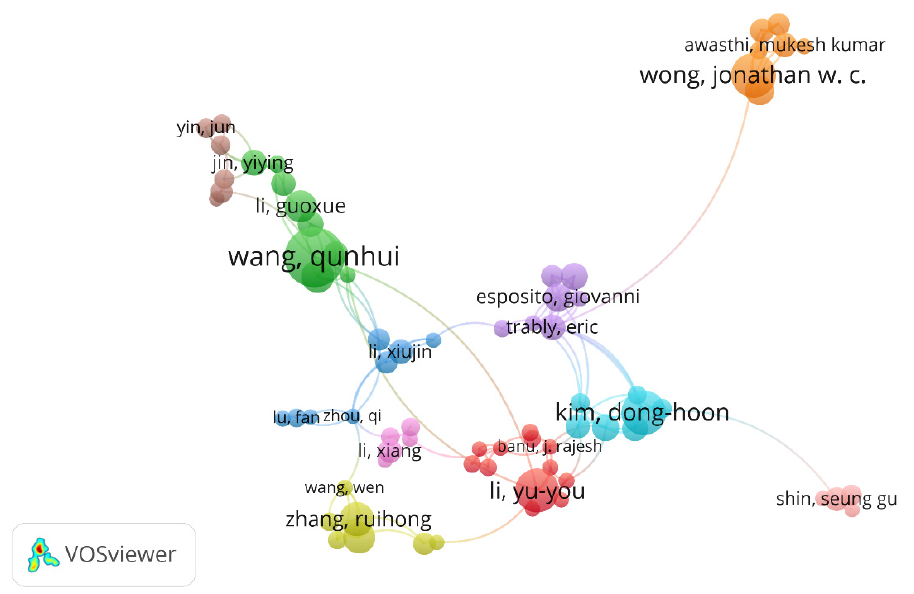
Figure 5. Knowledge domain map for the co-authorship network in FW studies.